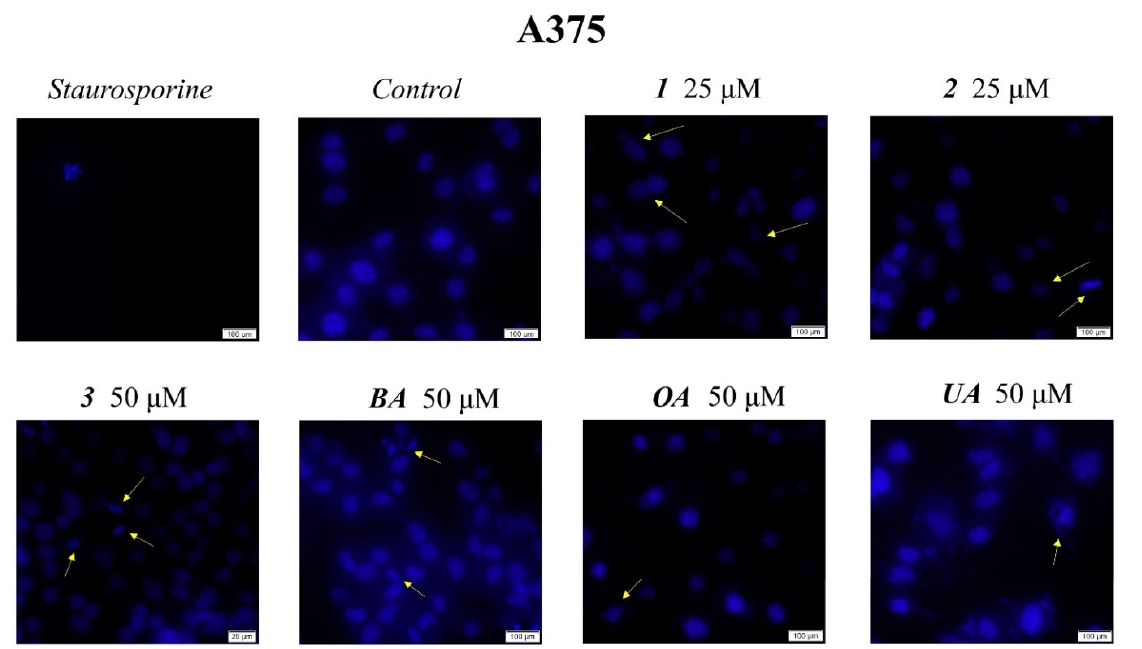
Figure 6. Nuclear staining using DAPI in A375 cells after treatment with 1 , 2 , and 3 (10, 25, and 50 µ M) for 24 h. The pictures were captured 24 h post-treatment. The staurosporine solution (5 µ M) was used as the positive control for apoptotic changes at the nuclear level. The yellow arrows represent signs of apoptosis, such as nuclear shrinkage, condensation, fragmentation, and cellular membrane disruption.